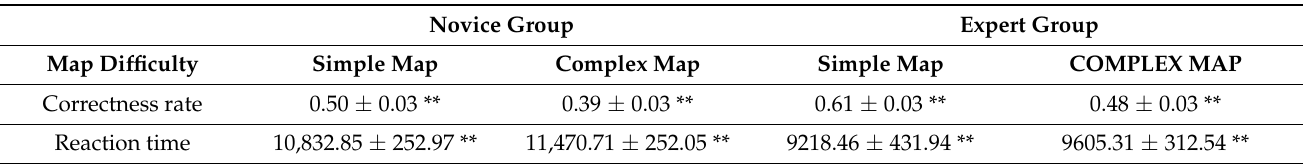
Table 4. List of behavioral results of the spatial working memory task for map recognition in directed scenarios (M ±